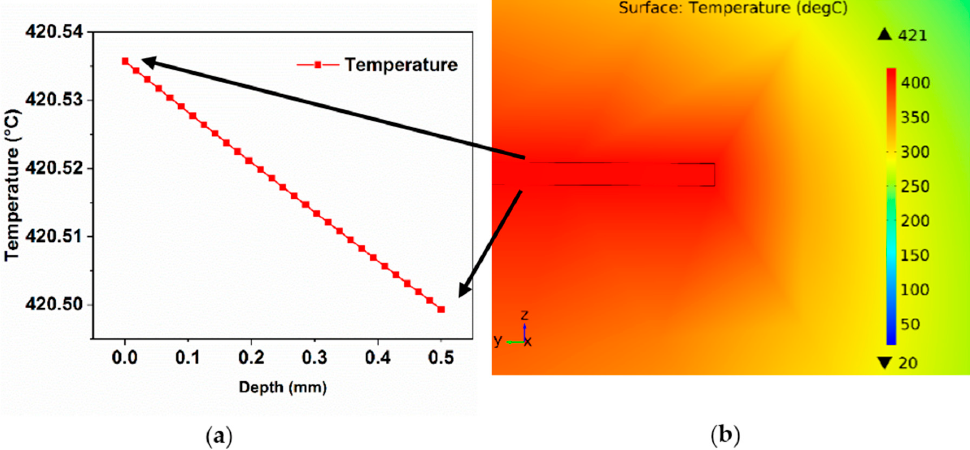
Figure A4. ( a ) The temperature versus the depth from the surface of the wafer; ( b ) The zoomed cross-sectional view of the temperature profile of the wafer.